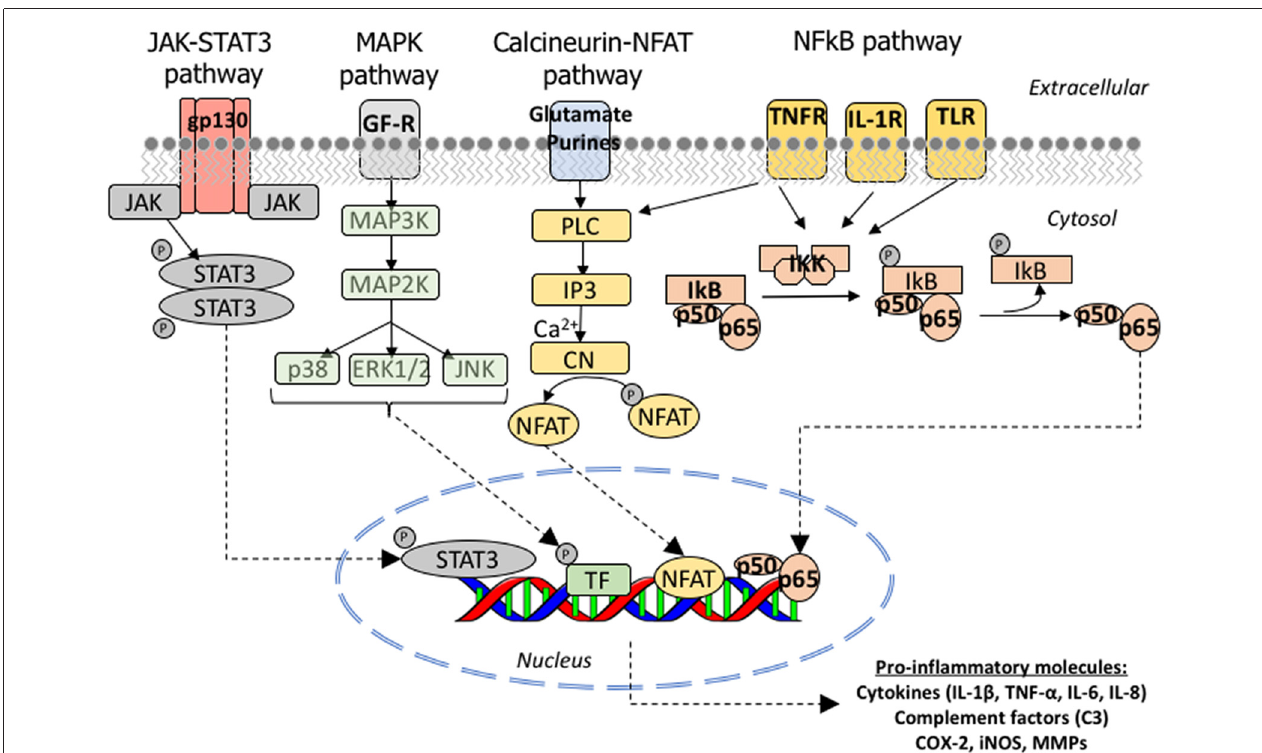
FIGURE 5 | Molecular signaling pathways involved in astrocyte reaction in AD. Cartoon illustrating the JAK/STAT3, MAPK, CN/NFAT and NF κ B signaling cascades. JAK/STAT3 pathway : the JAKs (JAK 1, 2, 3 and Tyk2) are tyrosine-kinases associated with the intracellular domain of cytokine receptors. The binding of a cytokine ligand to its receptor triggers a dimerization or oligomerization of the associated JAK and this leads to its transphosphorylation and activation. The activated JAK then phosphorylates key tyrosine residues in the cytokine receptor, which leads to the recruitment of STAT (STAT1, 2, 3, 4, 5A, 5B or 6) and a single tyrosine phosphorylation at the Y of its C-terminus. Once phosphorylated, STAT forms homo or heterodimers and is imported to the nucleus, where it complexes with other transcription factors, notably NFkB, to bind its target genes. MAPK pathway : the p38 mitogen-activating protein kinase (p38 MAPK) is a family of serine-threonine kinases of which p38 α is the most studied due to its ubiquitous expression at high levels. p38 α phosphorylates multiple substrates including transcription factors, DNA and RNA binding proteins, other serine-threonine kinases (including GSK3 β ), and cell cycle and pro-apoptotic proteins. Calcineurin/NFAT pathway : the phosphatase function of CN is activated upon the binding of calcium and calmodulin to its regulatory subunit. Once activated, CN removes several phosphate residues from the N-terminus of the transcription factors NFATc (nuclear factor of activated T cells) proteins, named NFATc1 to 4, and exposes their nuclear localization motif, leading to their rapid entry into the nucleus. NFATc targets are largely genes encoding cytokines, growth factors and their receptors, and cell adhesion proteins, as well as many microRNAs. NF κ B pathway : NF κ B is a heterodimeric transcription factor composed of the subunits p65/RelA and p50, which belong to the Rel family of proteins. It is normally located in the cytoplasm in an inactive form due to its binding to the inhibitor I κ B, which masks its nuclear localization signal located in the p65 subunit. Activation of IKK complex by certain extracellular signals can dissociate NF κ B and I κ B by promoting the phosphorylation of the I κ B- α , which is a necessary step for I κ B- α ubiquitination and subsequent degradation by the proteasome. Once free from I κ B, NF κ B can translocate to the nucleus and bind to the 10 base pair consensus-sequence GGGACTTTCC GGGRNNYYCC in the promoter of its target genes (NF κ B response elements). Abbreviations: CN, calcineurin; COX, cyclo-oxygenase; ERK, extracellular signal-regulated kinases; IL, interleukin; IL1-R, interleukin 1 receptor; iNOS, inducible nitric oxide synthetase; IP3, inositol-3-phosphate; JAK, Janus kinase; MAPK, mitogen-activated protein kinase; MMPs, matrix metalloproteases;